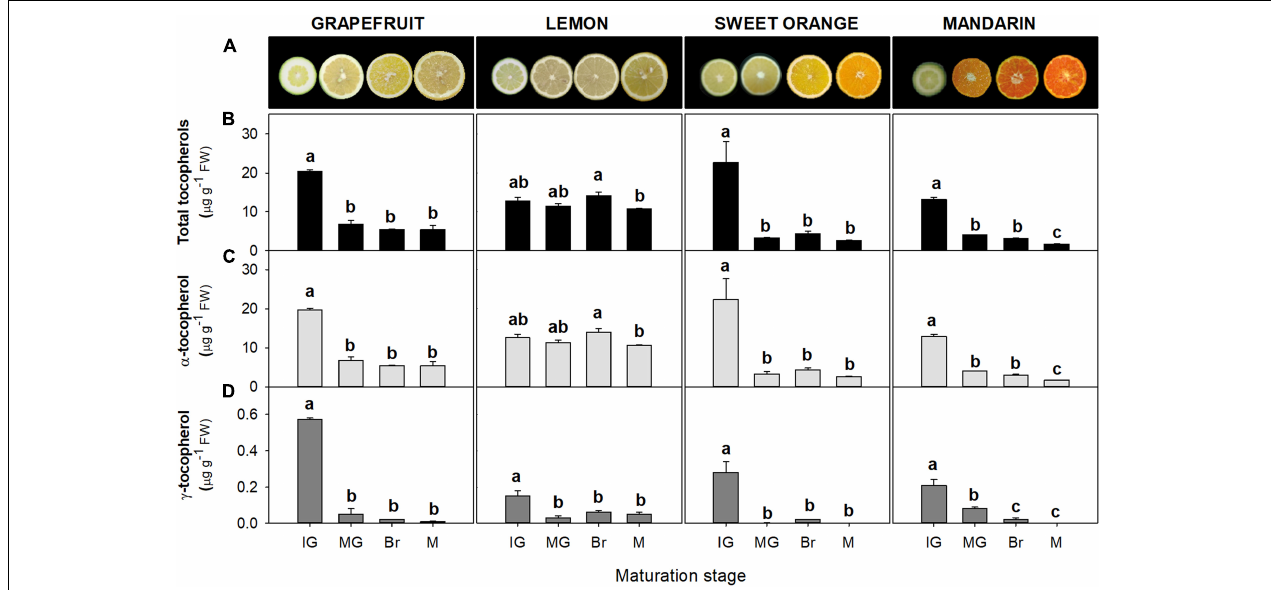
FIGURE 3 | Fruit internal appearance (A) and total tocopherol (B) , α -tocopherol (C) , and γ -tocopherol content (D) in the pulp during fruit maturation of grapefruit ( C. paradisi ), lemon ( C. limon ), sweet orange ( C. sinensis ), and mandarin ( C. clementine ). Contents are expressed as µ g g – 1 of fresh weight. The data are mean ± SE of at least two replicates ( Supplementary Table 10 ). Maturation stages correspond to immature green (IG), mature green (MG), breaker (Br), and mature (M). Different letters indicate significant mean differences among maturation stages for each fruit specie (Tukey’s test, p ≤ 0.05).